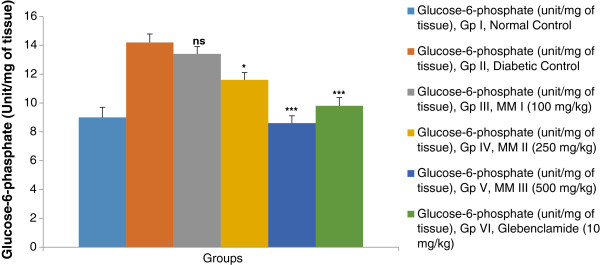
Effect of Melastoma malabathricum Linn. (MM) on level of glucose-6-phosphate at different concentrations on STZ induced diabetic rats, compared to standard drug Glibenclamide; values are mean ± SEM; n = 6; *P < 0.05; **P < 0.01; ***P < 0.001; P > 0.05 is considered as non-significant (ns).